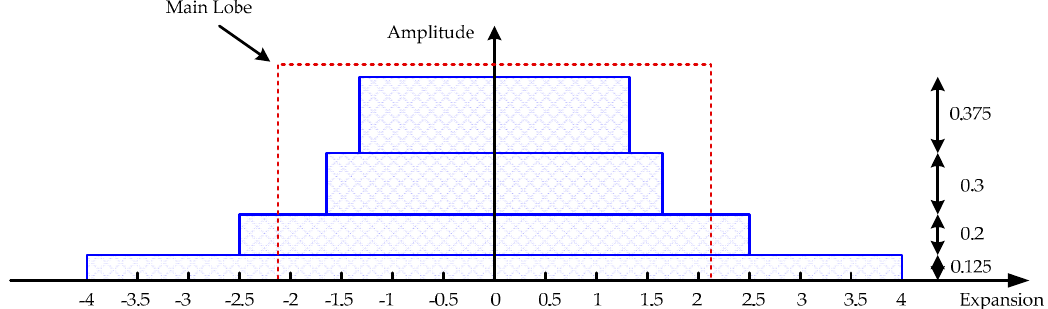
Figure 4. Sketch map of envelope with random section lengths. The rectangles with blue lines are sketch maps of the envelope of four sections after MPSM.